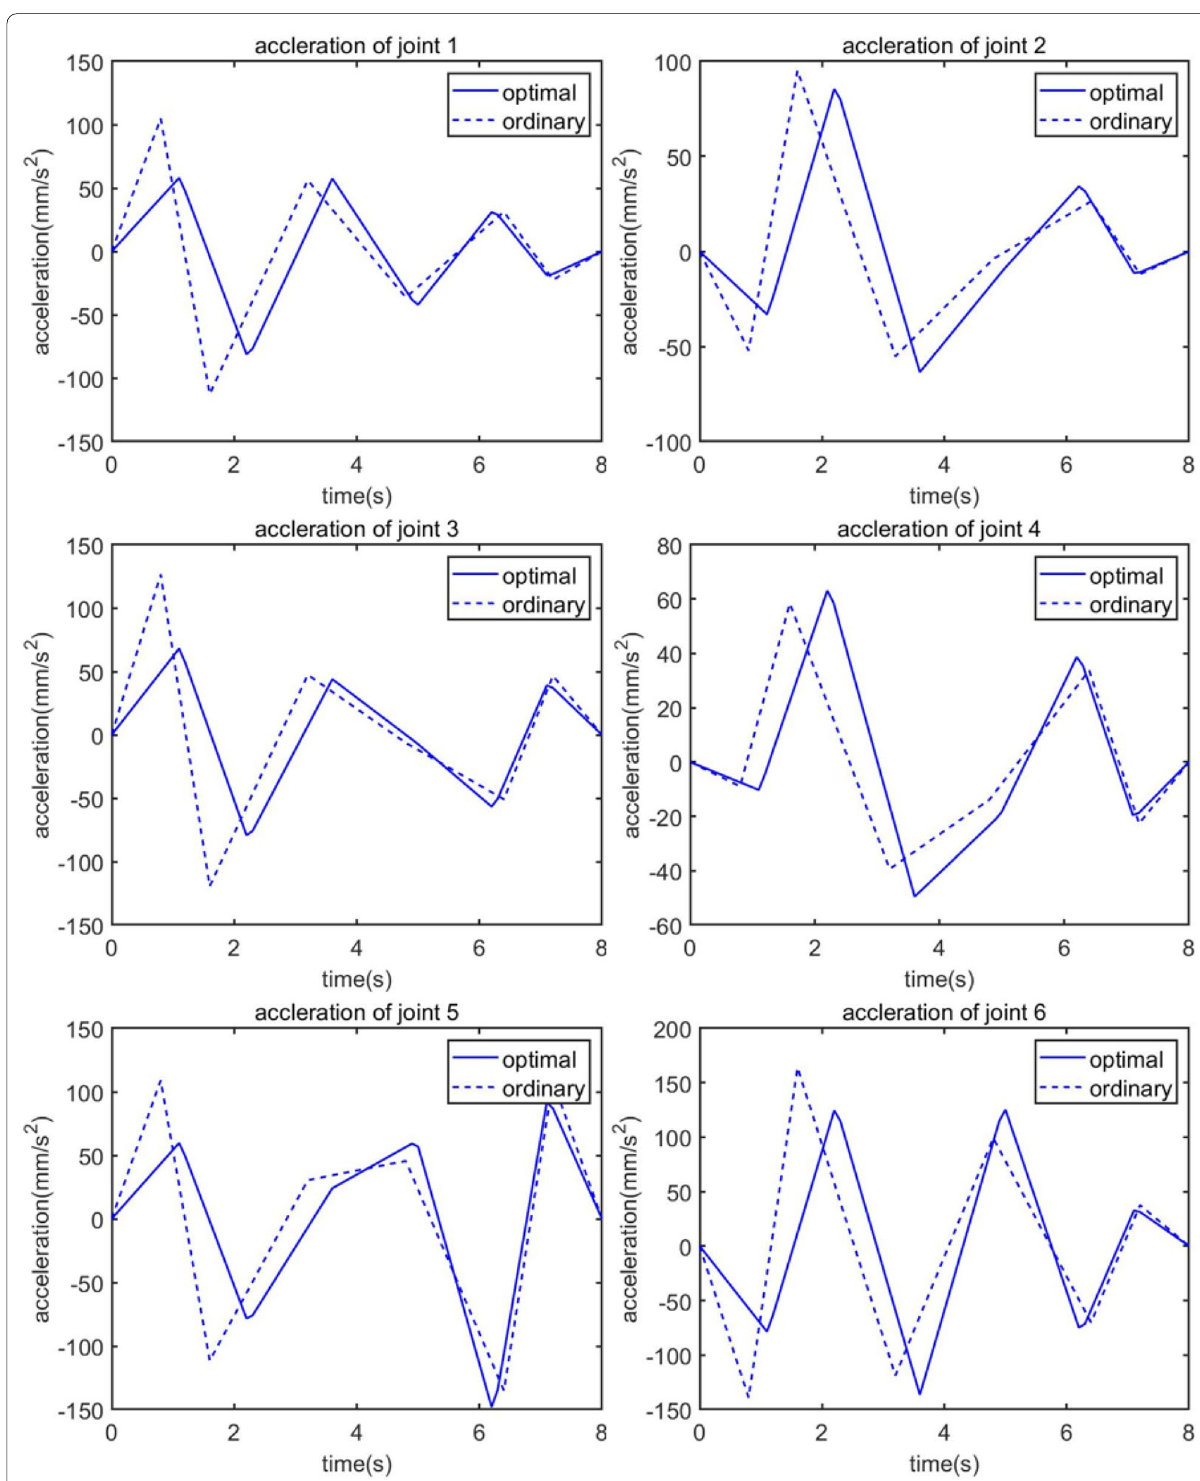
Figure 12 Acceleration of